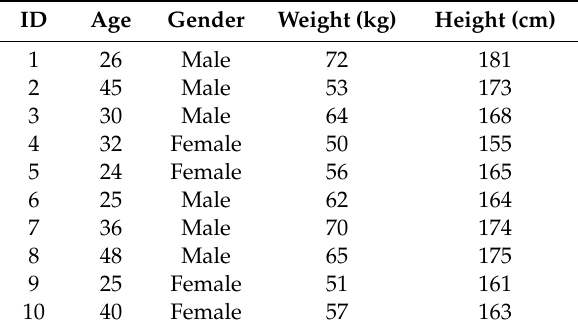
Table 2. Details of volunteers.